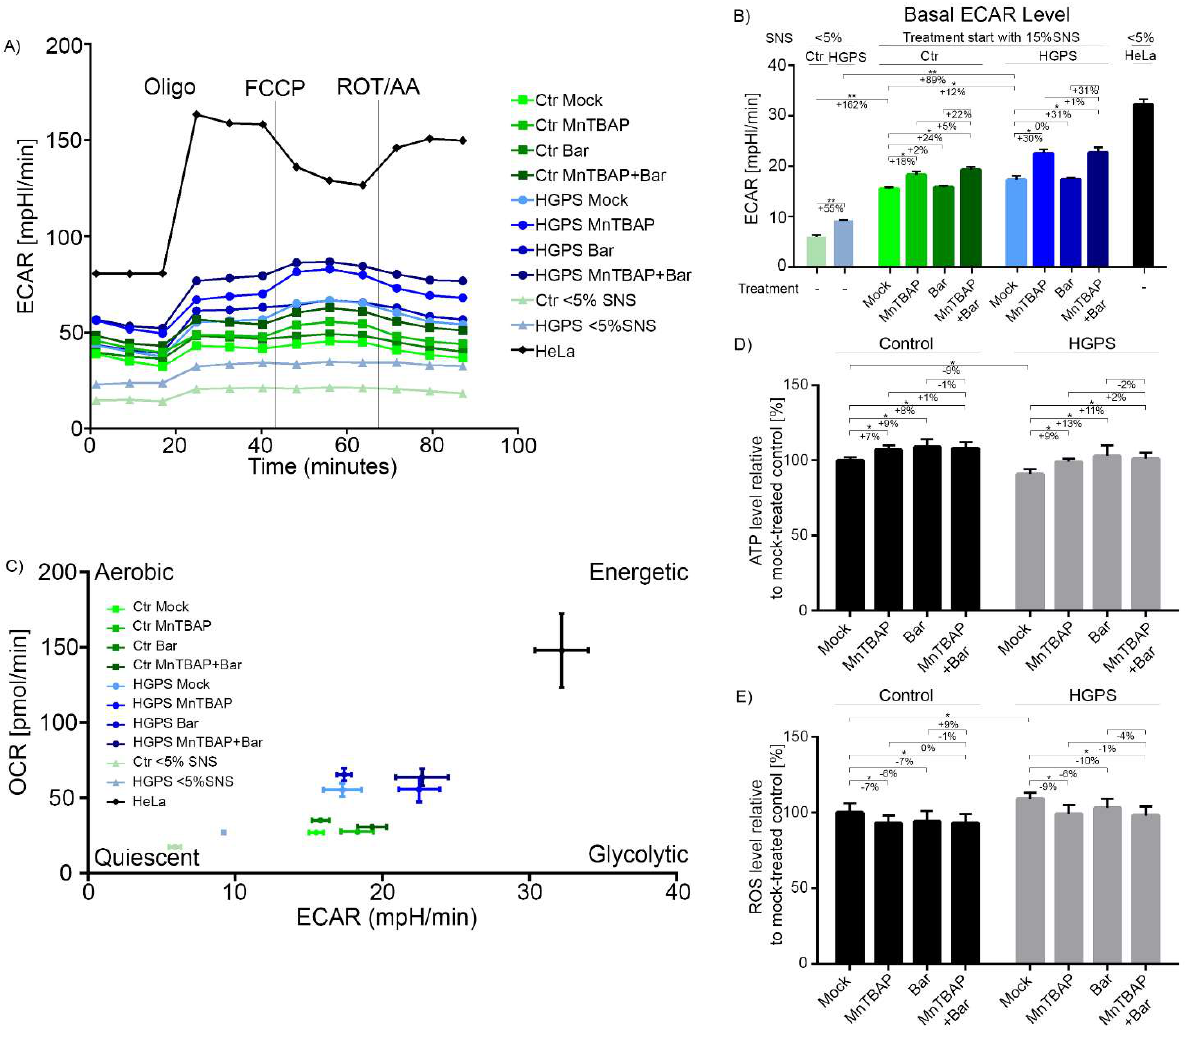
Figure 5. Effect of combination treatments on glycolysis, ATP, and ROS levels. ( A – E ) Extracellular acidification (ECAR) was determined using a Seahorse XF96 Flux analyzer after cells were treatet with a mock solution, 5 µM MnTBAP, 1 µM Bar, or the MnTBAP/Bar combination for 9 d. ( C ) Energy phenotype profile displayed as a scatter plot of OCR and ECAR. ( D ) Intracellular ATP levels were measured using a CellTiter-Glo luminescence ATP assay. ( E ) Intracellular ROS levels were determined based on oxidized dichlorofluorescein (DCF) levels measured using DCFDA Cellular Detection Assay. Graphs show the mean ± SD ( n = 3; * p < 0.05, ** p < 0.01).